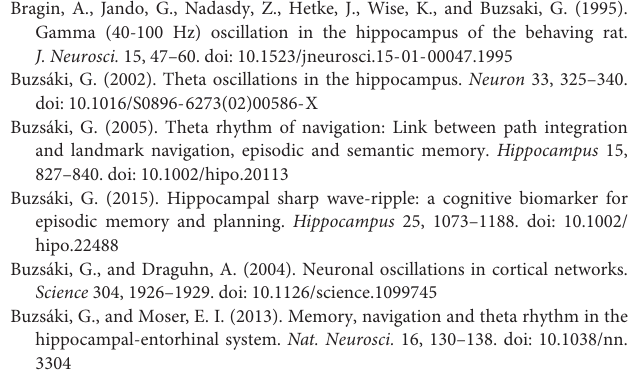
FIGURE S1 | (A) Mean absolute (i.e., non-normalized) power in the delta and theta bands for individual sessions. Upper, middle and lower panels show data from Rat2_Session1, Rat3_Session1, and Rat11_Session2, respectively. (B) Average absolute power in the delta and theta bands across all sessions of each rat. Upper, middle and lower panels show data from Rat2_Session1, Rat3_Session1, and Rat11_Session2, respectively. Only data from the left hemispheres are shown. FIGURE S2 | (A) Inter-hemispheric phase coherence of 35 individual runs (red) and mean coherence of the session (black, Rat3_Session10). (B) Mean inter-hemispheric phase coherence in the delta (upper) and theta (lower) bands across 35 runs of the same session. (C) Mean inter-hemispheric phase coherence over 385 runs from 11 sessions (solid line). Dashed lines depict ± SEM. FIGURE S3 | (A) Latency from the end of treadmill running to the moment animals get the water reward at the maze corners ( p = 0.92, repeated measures ANOVA). Circles represent means and error bars represent ± SEM ( n = 11 sessions from 3 rats). The mean latency of each session is represented in colored lines. (B) Percentage of correct alternations across the 35 runs ( n = 11 sessions from 3 rats). VIDEO S1 | Representative example of the treadmill-maze task. The video shows two consecutive laps on the apparatus during a typical recording session. Notice that the rat alternates among the left and right arms of the